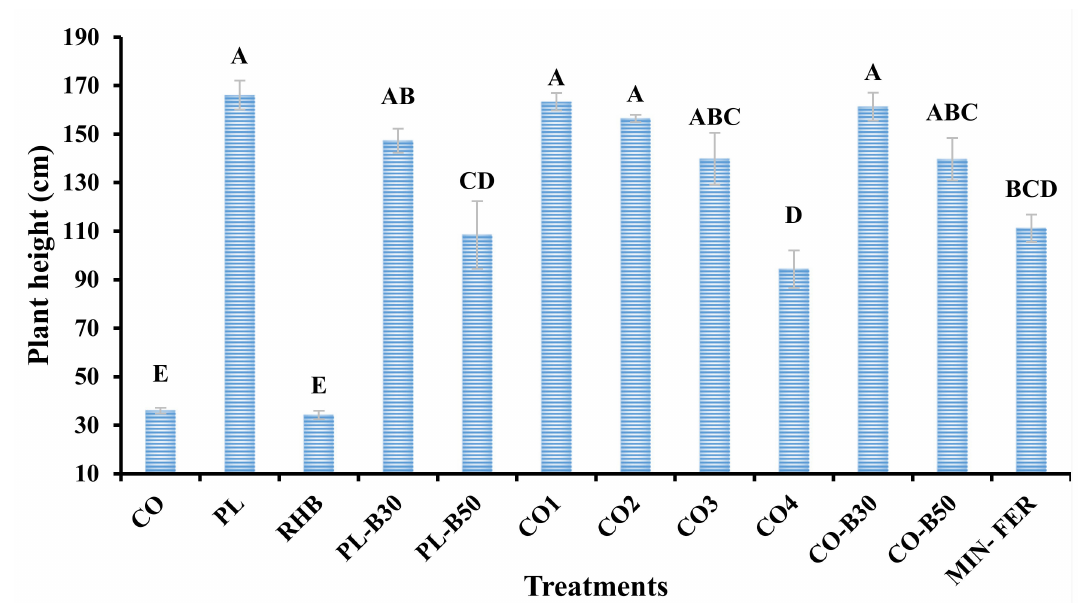
Figure 2. Maize plant height at harvest according to treatments. Key: CO, control; PL, poultry litter; RHB, rice husk biochar; PL-B30, poultry litter blended with 30% biochar; PL-B50, poultry litter blended with 50% biochar; CO1, PL compost, CO2, CO3, CO4; CO-B30, PL compost blended with 30% biochar; CO-B50, PL compost blended with 50% biochar; MIN-FER, mineral fertilizer at recommended rate. Different letters indicate significance difference detected between plant height between treatments according to Tukey test set at 95% confidence level ( α =